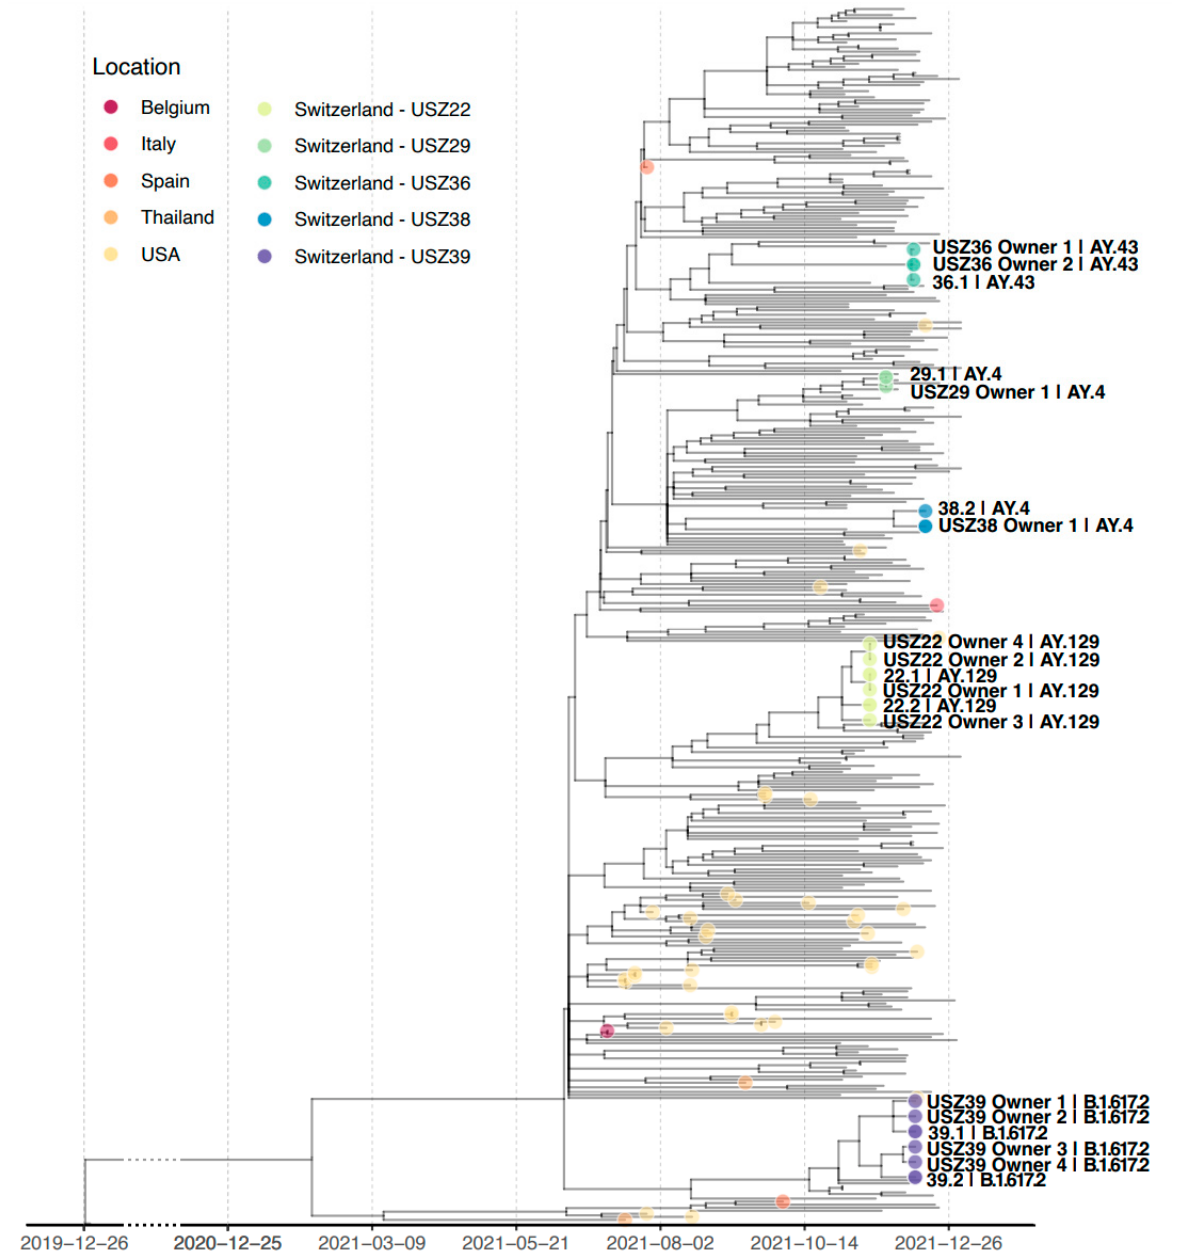
Figure 3. Time-scaled maximum-likelihood phylogenetic tree with viral sequences from companion animals and owners of households USZ22, USZ29, USZ36, USZ38, and USZ39. A total of 330 se- quences are included to represent the genetic diversity of the SARS-CoV-2 Delta variant in Zurich from November 2021 to January 2022 and the genetic diversity of the SARS-CoV-2 Delta variant in companion animals worldwide (see Materials and Methods Section for a detailed description of the alignment). Sequences from the study and companion animals are indicated with a dot in the tree; only sequences from the study are labeled with the sample name and pangolin lineage. Tip color indicates the location of the sequence. Time scale is shown at the bottom of the figure; a clock rate of 0.0008 substitutions/site/year is assumed for the reconstruction of the time-scaled tree. Branch length in the tree represents evolutionary distance, i.e., substitutions per site. Reference sequence Wuhan/Hu-1/2019 is used as an outgroup to root the